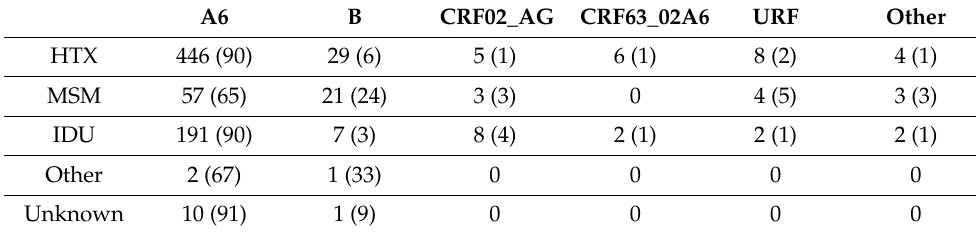
Table 3. Distribution of HIV-1 subtypes among the transmission categories.